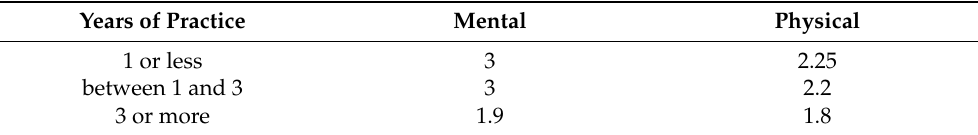
Table 5. Years of experience in mindfulness and perception of the negative effects of the syndemic. Years of